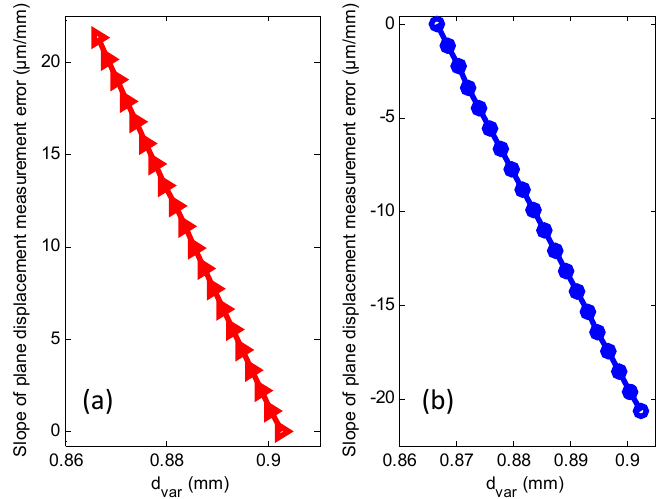
Figure 7. Slope of the coplanar displacement measurement error of the X-axis ( a ) and Y-axis ( b ).